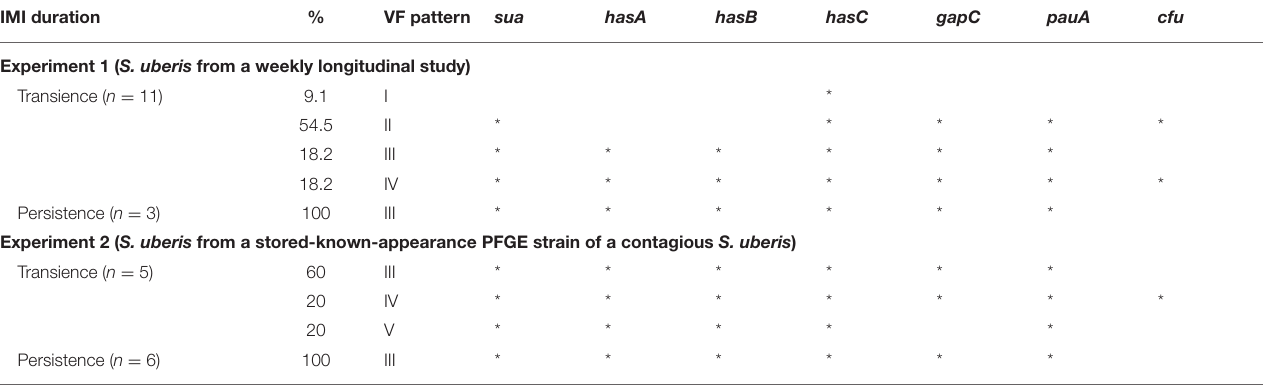
TABLE 2 | Virulence patterns of Streptococcus uberis obtained from a weekly longitudinal study in experiment 1 (EXP1) and from a stored-known-appearance PFGE strain of a contagious S. uberis in experiment 2 (EXP2) between transient and persistent intramammary infection (IMI). IMI duration % VF pattern sua hasA hasB hasC gapC pauA cfu Experiment 1 ( S. uberis from a weekly longitudinal study) Transience ( n =